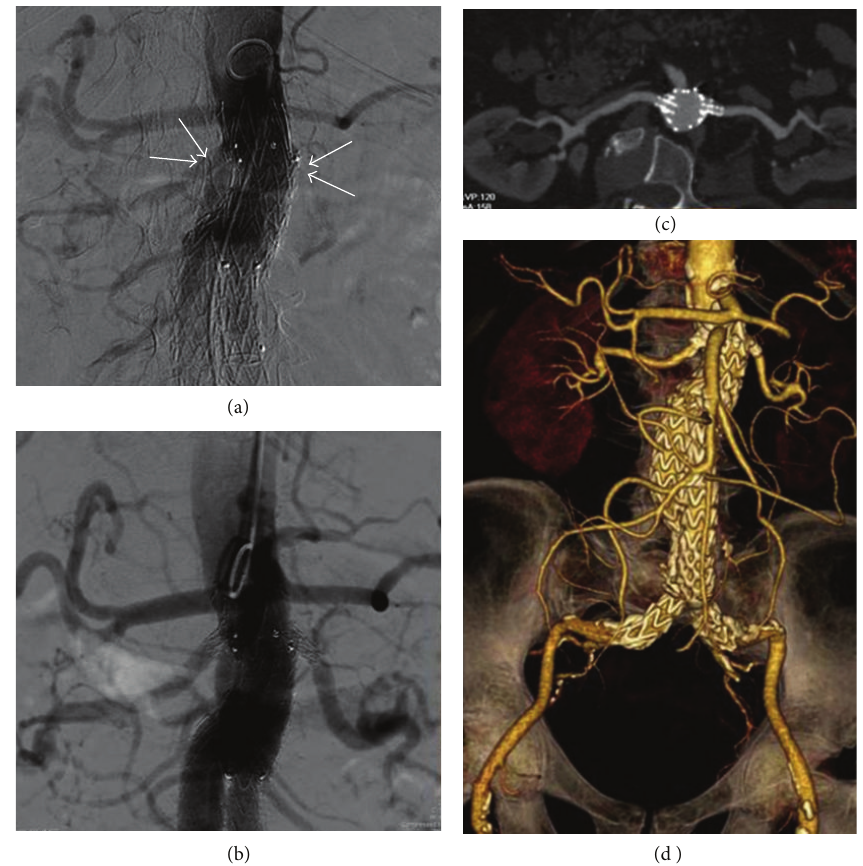
Figure 3: Selective angiography at the proximal extremity of the EG (a) showed the overstenting (arrows) of the origin of both the renal arteries. Complete revascularization after bilateral stenting (b). Follow-up CT-A: complete reperfusion of the parenchyma (c) as well as persistent exclusion of the aneurysm and absence of endoleak